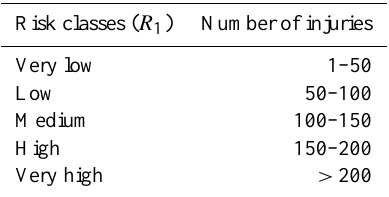
Table 8. Relative risk classes and range of values for injuries.